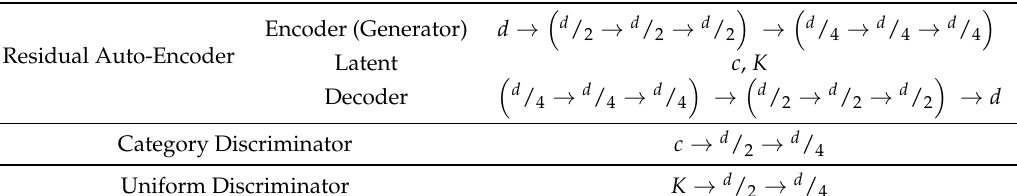
Table 4. Structure of our semi-supervised deep adversarial